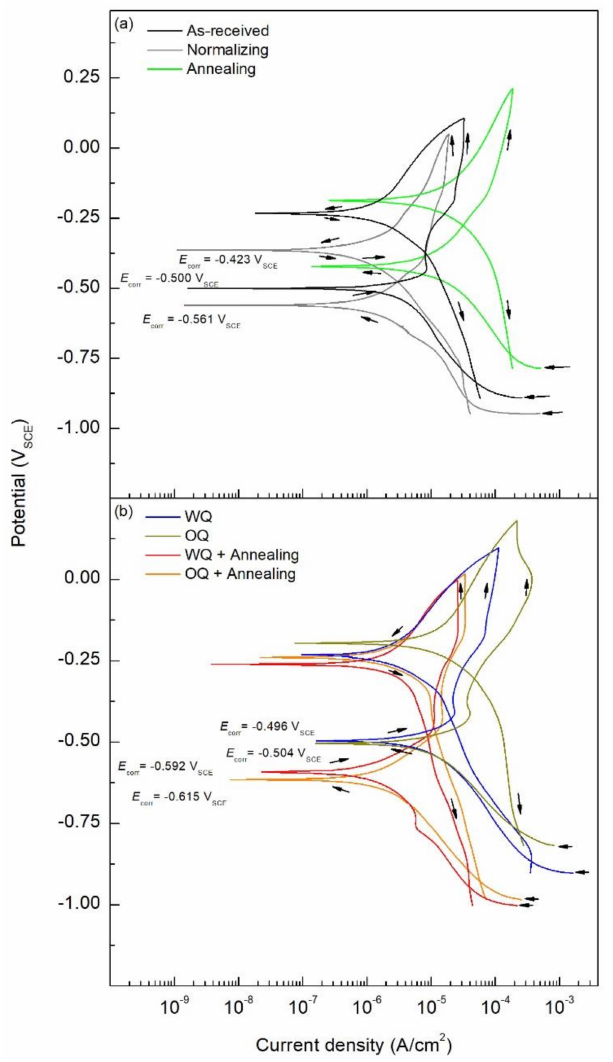
Figure 5. CPP of thermal treated CS specimens in FA pore solution containing 0.6 M NaCl: ( a ) slow cooling rate, and ( b ) fast cooling